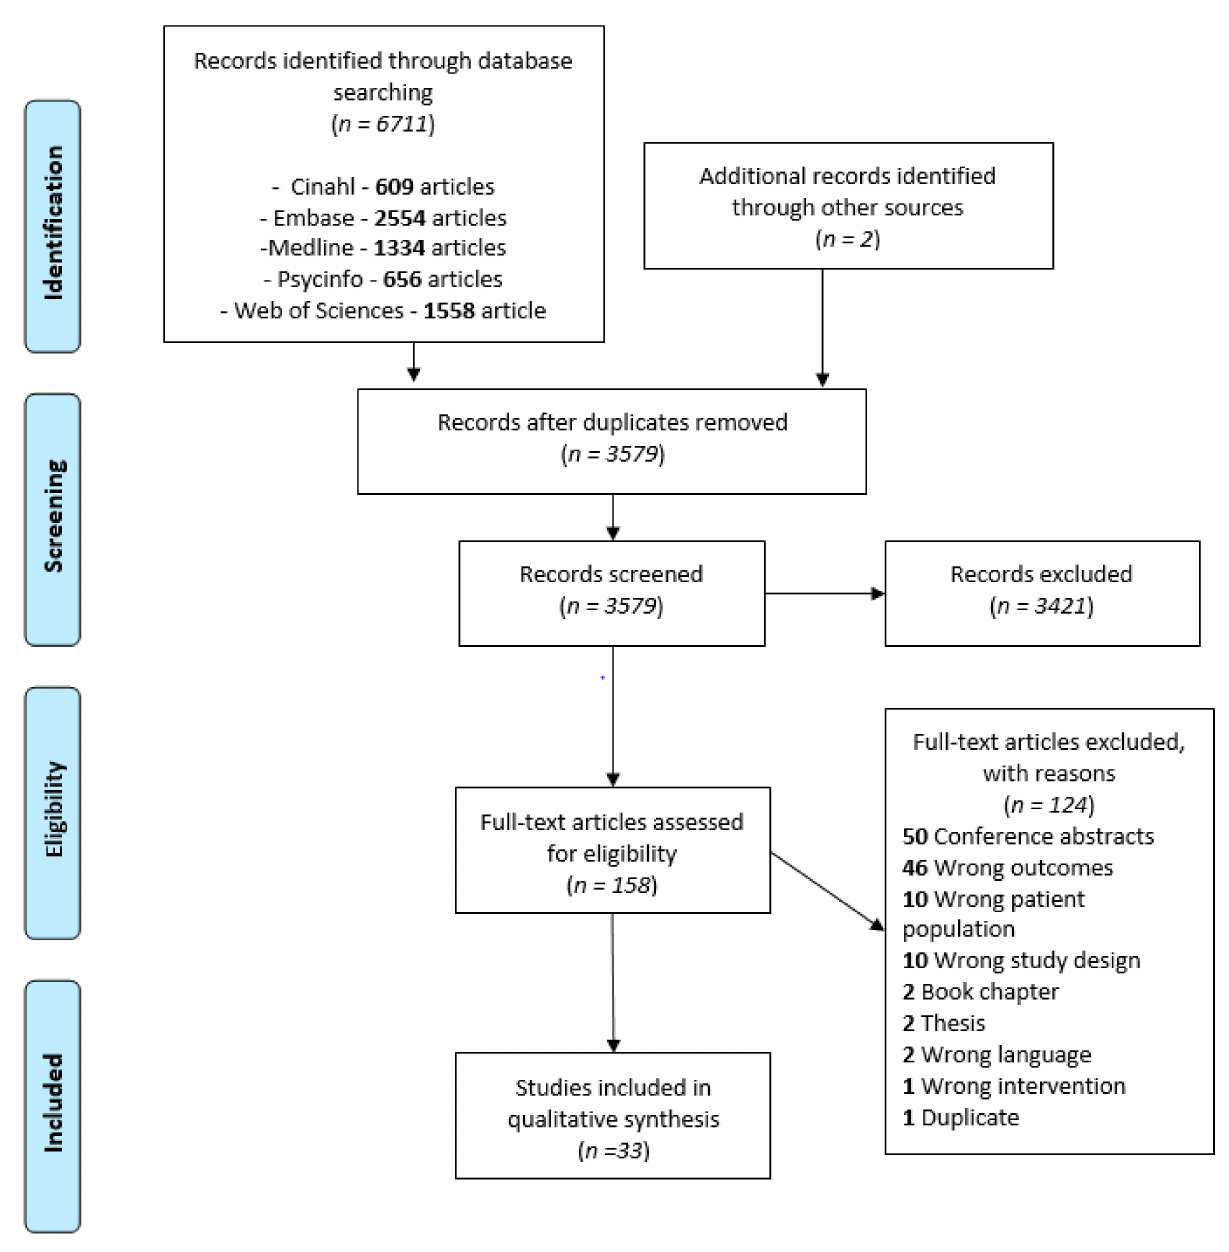
Figure 1. PRISMA flow chart of studies selection